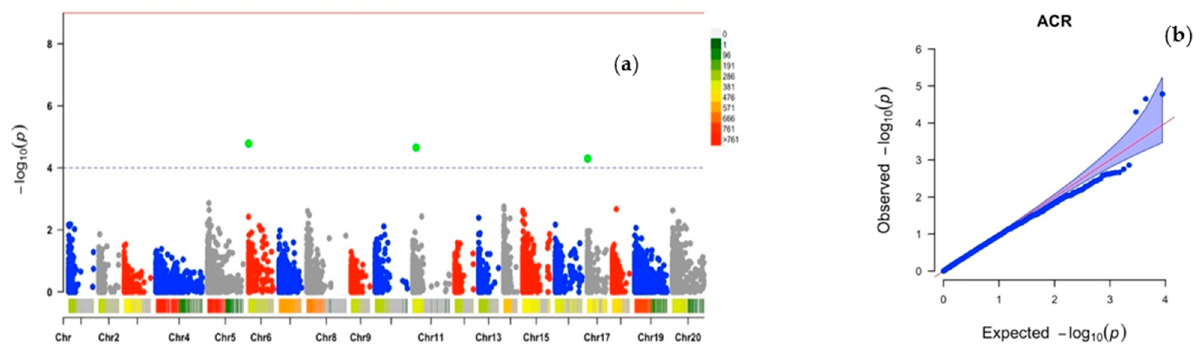
Figure 2. Genome-wide association analysis for average crossability rate (ACR) in D. alata : ( a ) Manhattan plot, ( b ) quantile–quantile (Q–Q) plot. Vertical bars relate to the 20 yam chromosomes, green dots indicate chromosomes with influence on the target trait.